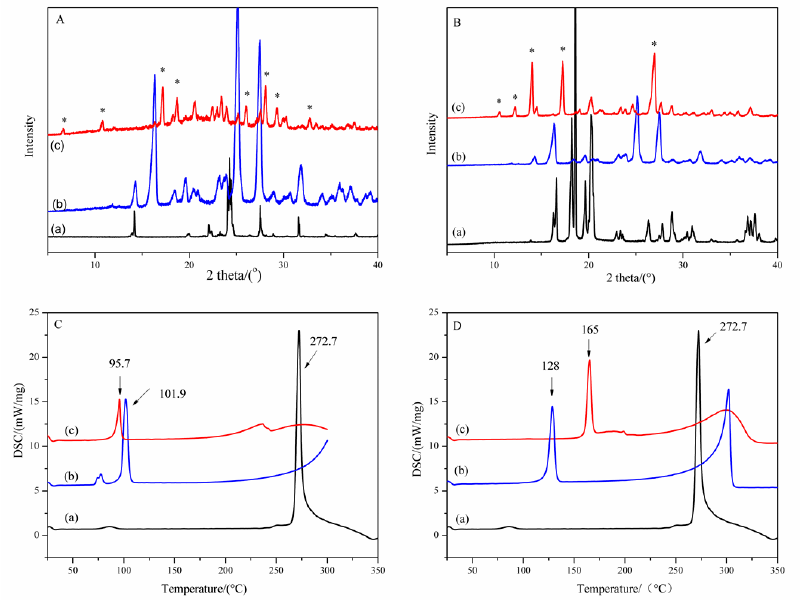
Figure 1. PXRD patterns ( A,B ) and DSC curves ( C,D ) of the GA-based cocrystal system (*: peaks for the new crystalloid complex) A, C: ( a ) GA; ( b ) glutaric acid; ( c ) GA-glutaric acid cocrystal in GA / glutaric acid equimolar ratio; B, D: ( a ) GA ( b ) succinimide; ( c ) GA-succinimide cocrystal in 1:2 GA / succinimide molar ratio.